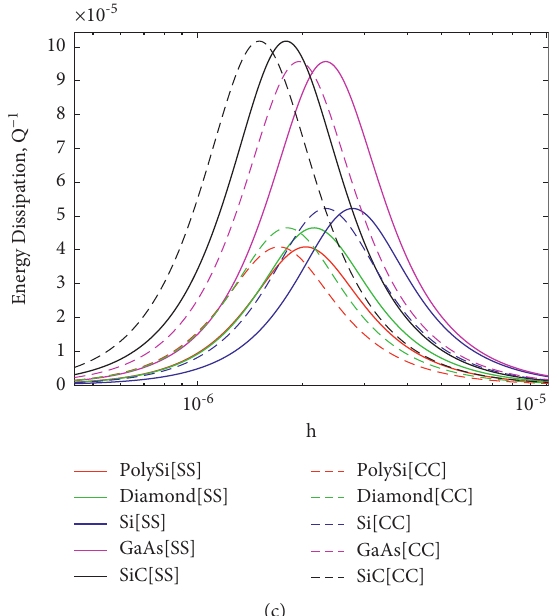
Figure 4: Comparison of energy dissipation, Q − 1 vs. thickness, h of a rectangular plate for simply supported (SS) and clamped-clamped (CC) boundary conditions vibrating in second mode with varying dimensionless length scale parameters ( l / h ): (a) l / h � 0, (b) l / h � 0.5, and (c) l / h �